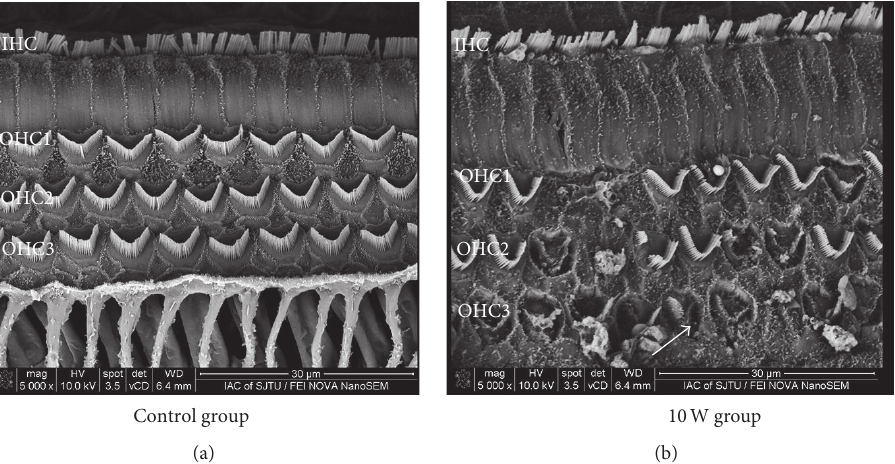
Figure 3: SEM image of the basal turn of a cochlea immediately after applying CO 2 laser irradiation. (a) Image of the basal turn in the control group. The stereocilia and cuticular plates of the inner and outer hair cells and supporting cells showed a normal configuration. OHC1: first line of the outer hair cells; OHC2: second line of the outer hair cells; OHC3: third line of the outer hair cells; IHC: inner hair cells. Scale bar: 30 𝜇 m. (b) Image of the basal turn after applying 10W CO 2 laser irradiation. Most of the outer hair cells had collapsed and derangements of the stereocilia were observed. Parts of the cells were missing, particularly in the third row of the outer hair cells (OHC3) in the basal turn (arrow), but the inner hair cells showed a normal configuration. Scale bar: 30 𝜇